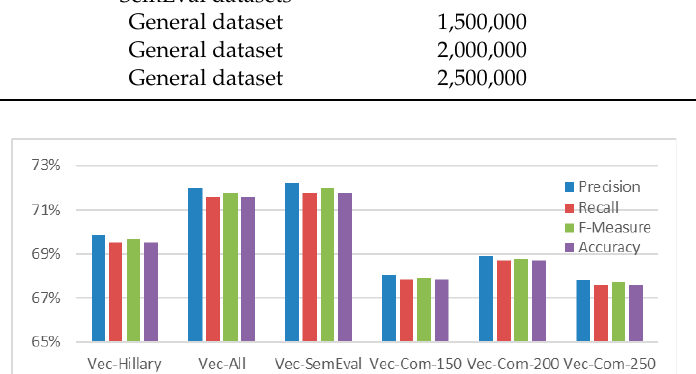
Figure 3. The performance of sentiment classification using different Word2Vec models. Table 1. Datasets for training word embedding models for sentiment classification.